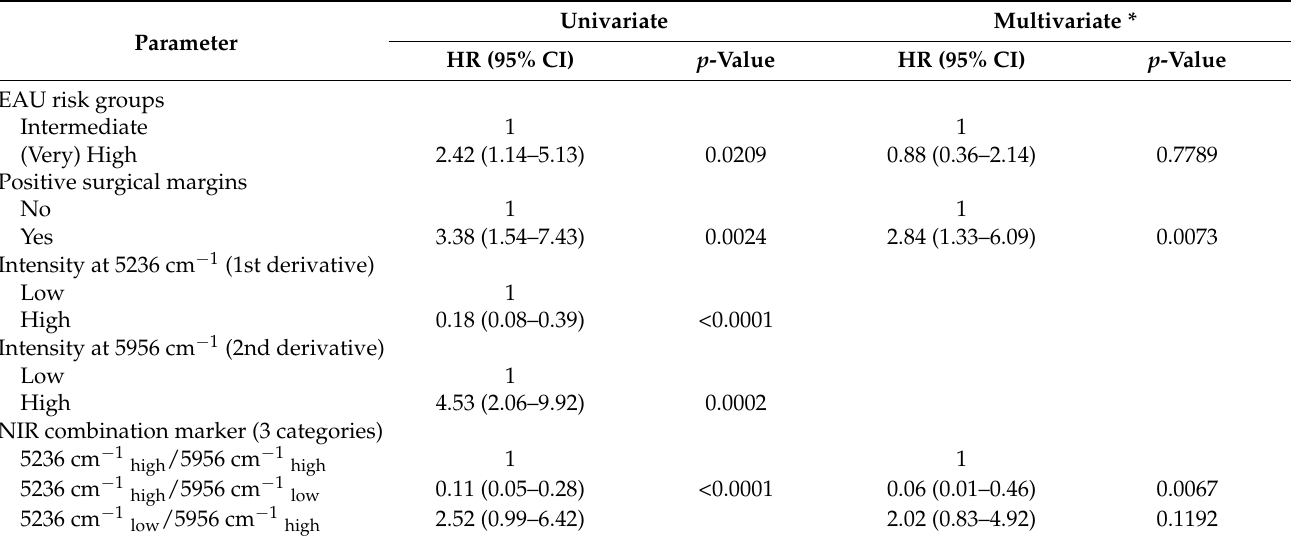
Table 2. Cox proportional hazard model for